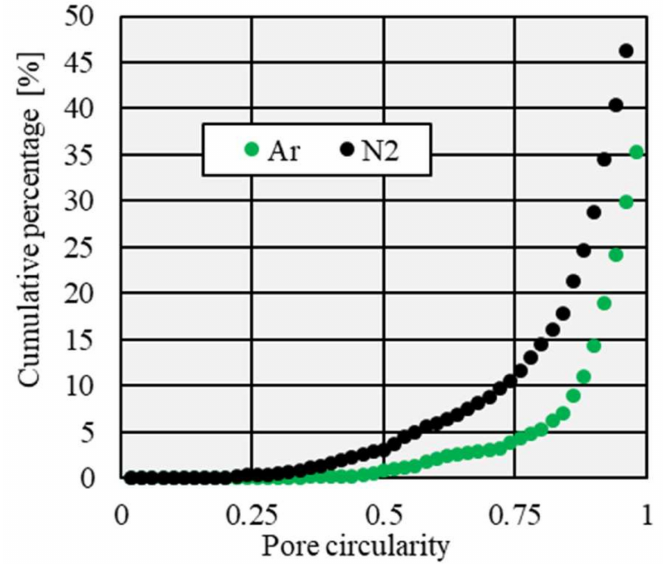
Figure 4. Cumulative percentage of pore circularity in the AB condition for specimens produced under an argon and nitrogen protective atmosphere.